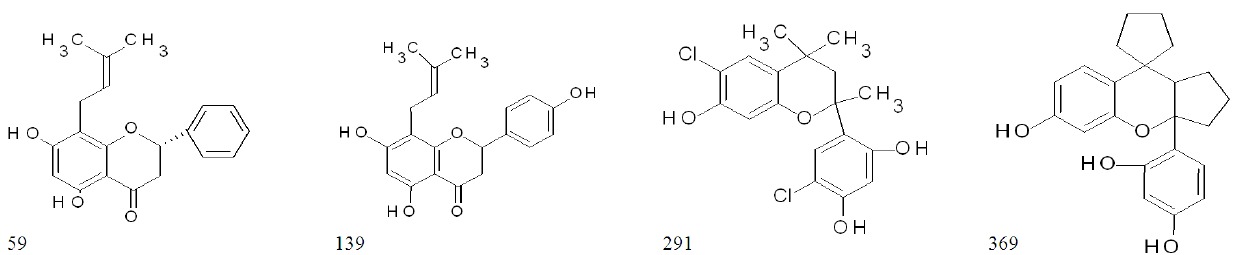
Figure 4. The four most active anti-biofilm flavonoids identified in this